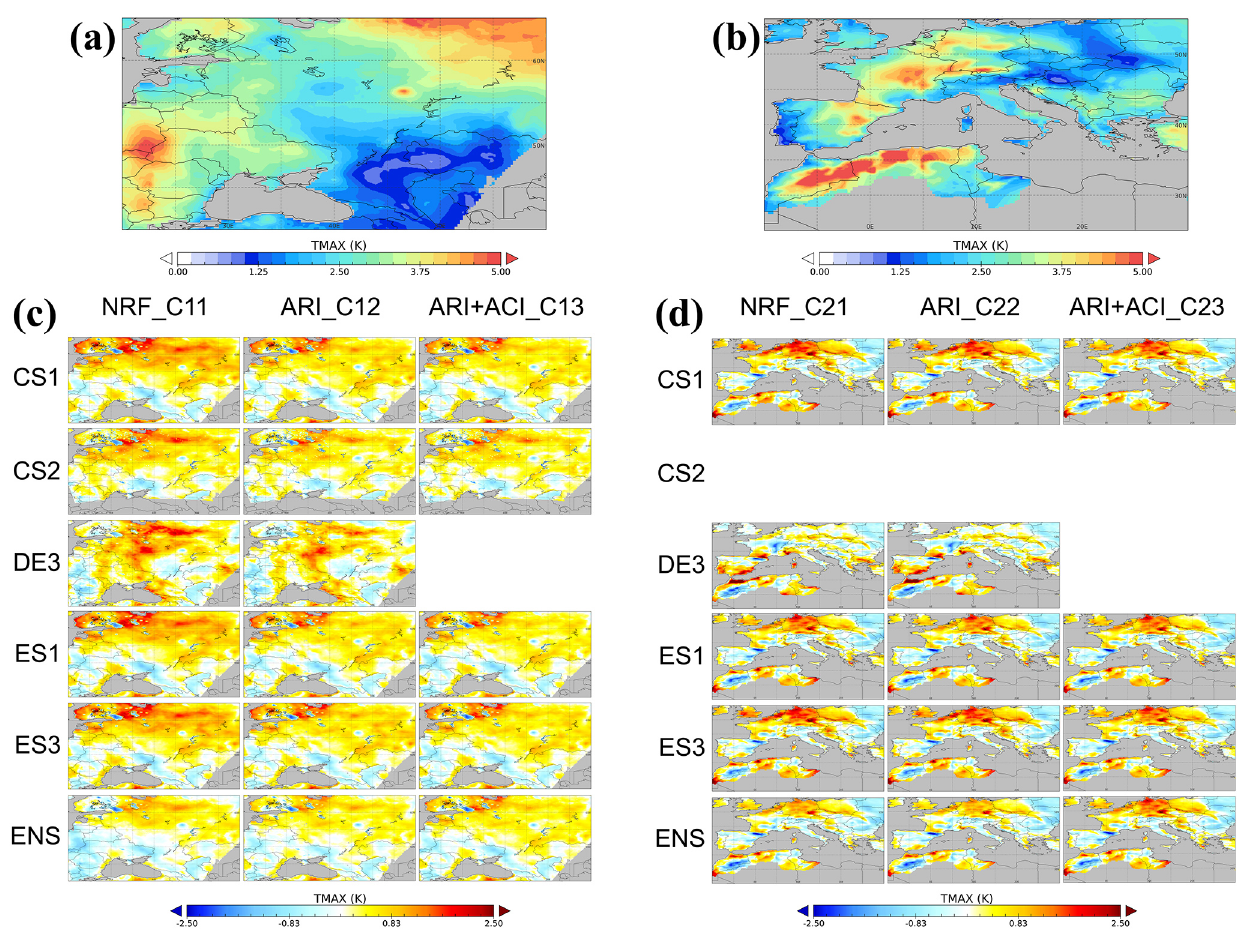
Figure 8. Standard deviation (SD) of the maximum temperature (TMAX) for the fire (a) and dust (b) episodes, as derived from the E-OBS database (in K). The panels below represent the bias for the standard deviation of the fires (c) and dust (d) episodes of each simulation with respect to the E-OBS